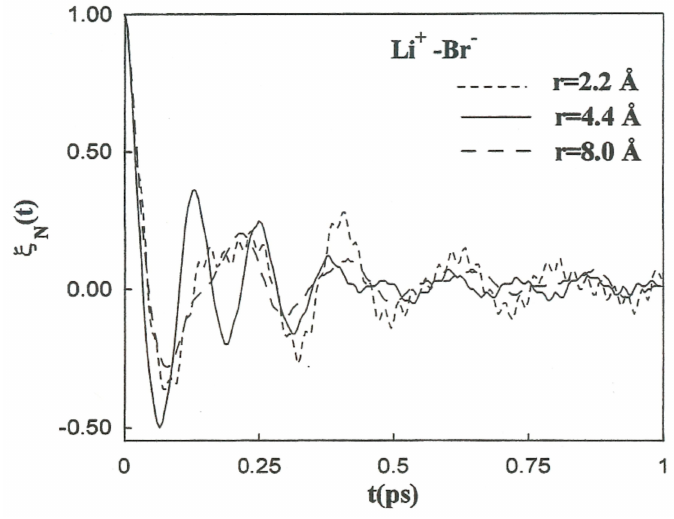
Figure 10. Normalized friction kernels for the Li + -Br − ion pair at various interionic separations.